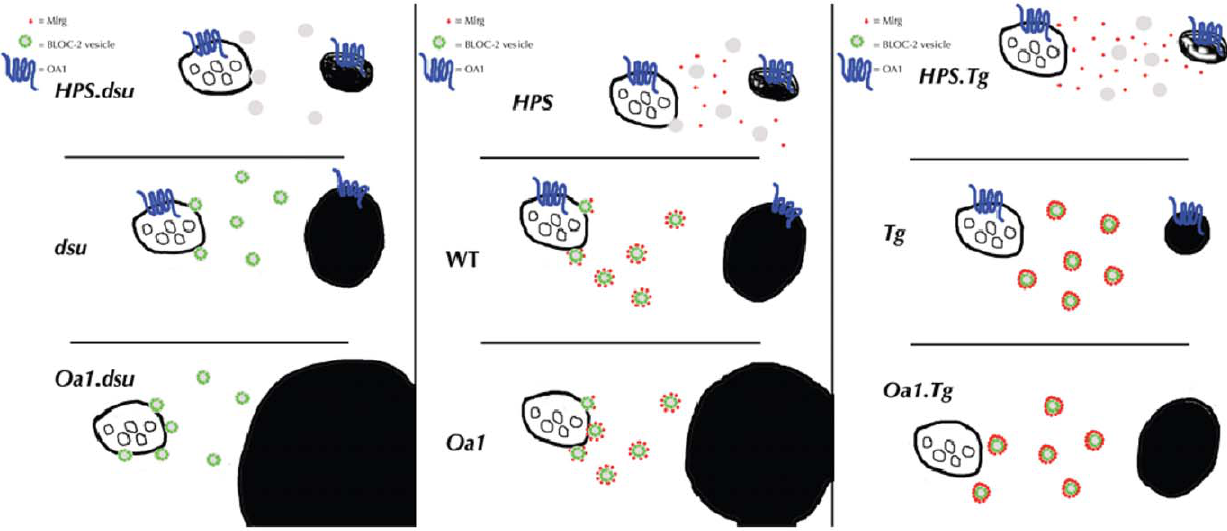
Figure 7. Model of melanoregulin function in melanosome biogenesis. These results are consistent with a hypothetical and testable model in which melanoregulin functions as a negative regulator of vesicle fusion with cytoplasmic components required for melanosome biogenesis. The panels in the diagrams are analogous to the panels in Figures 2 and 4, and show both a multivesicular body/endosome and a mature/pigmented melanosome as two stages in the biogenesis of melanosomes. HPS BLOC-2 forms a putative vesicle transport complex, or part of a vesicle system required for moving proteins required for melanosome biogenesis. Melanoregulin acts as a negative regulator of membrane fusion between BLOC-2 and the late endosome/early melanosome. Oa1 acts as a permissive gatekeeper, allowing components of melanosome biogenesis to accumulate up to a certain point, at which time it initiates (or turns off) a signalling cascade that prevents further accumulation of pigment-producing components. These features are compatible with the results presented here, and predict the results of future experiments that can be performed to test the tenets of this model.